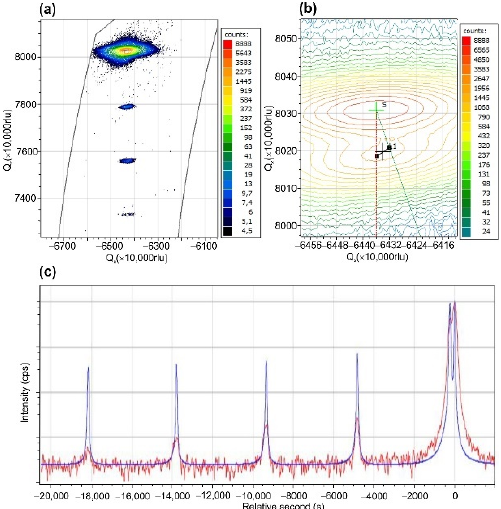
Figure 5. Results of high-resolution X-ray diffraction analysis of 100 × {GaN 1.5 /AlN 16 } MQW structure: ( a , b ) RSMs of asymmetric (11–24) peak plotted at different magnifications; ( c ) measured and simulated (0002) ω /2 θ scans.